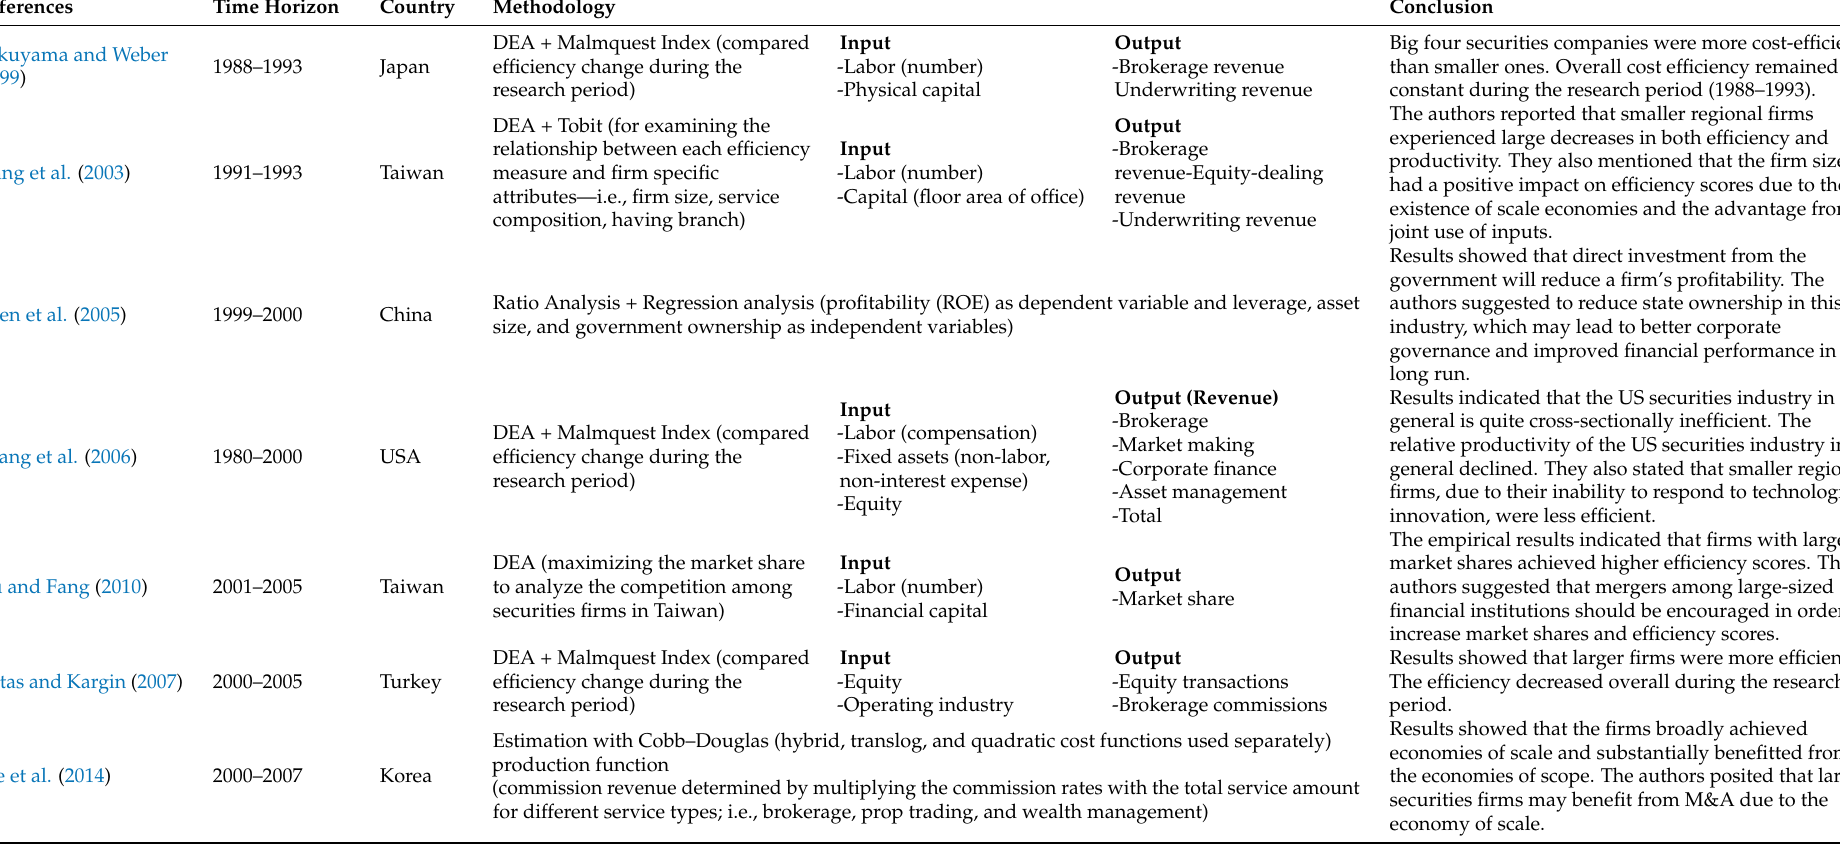
Table 1. Literature matrix for studies measuring efficiency/performance of securities